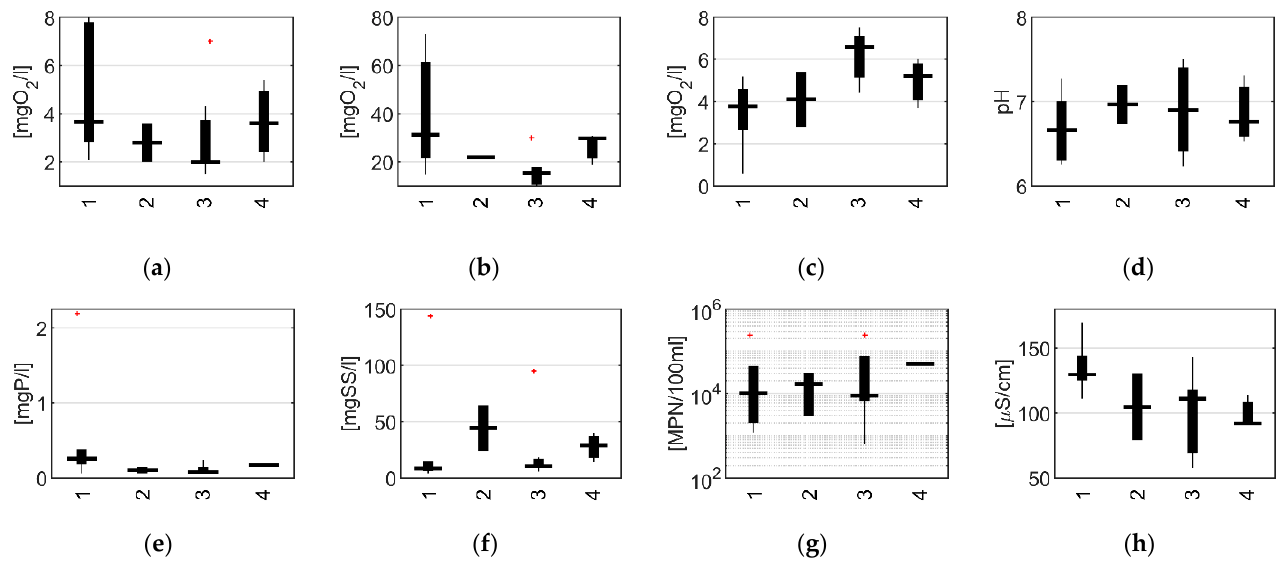
Figure 6. Temporal distribution of conventional constituents in C6: ( a ) CBOD; ( b ) COD; ( c ) DO; ( d ) pH; ( e ) total P; ( f ) total suspended solids; ( g ) TC; ( h ) EC.